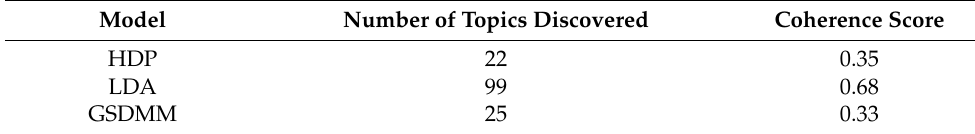
Table 3. Results of Topic Modeling Algorithms.